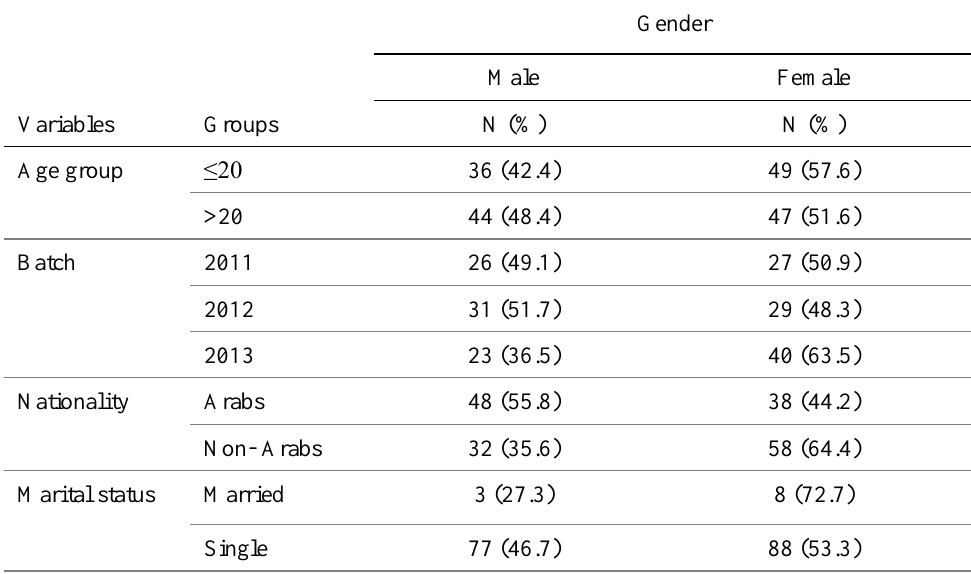
Table 1: Participant descriptive characteristics